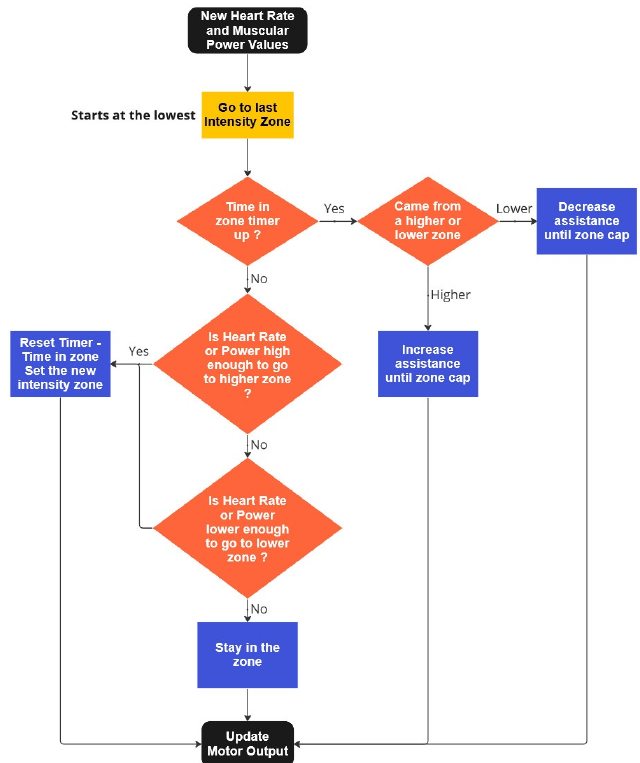
Figure 4. Flow diagram of the cardiac zone approach.